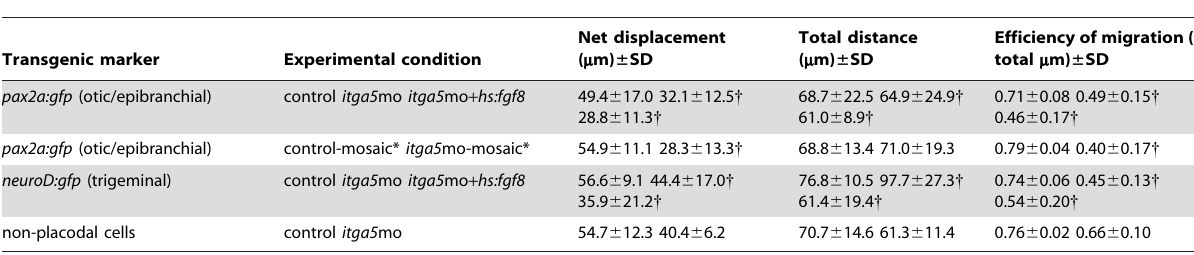
Table 1. Knockdown of itga5 impairs the efficiency of directed cell migration.